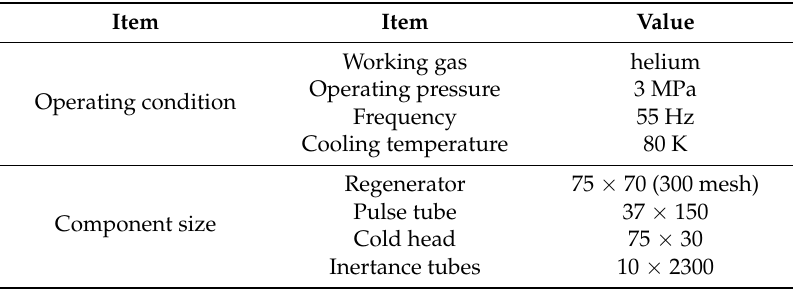
Table 1. Operating conditions and component size.